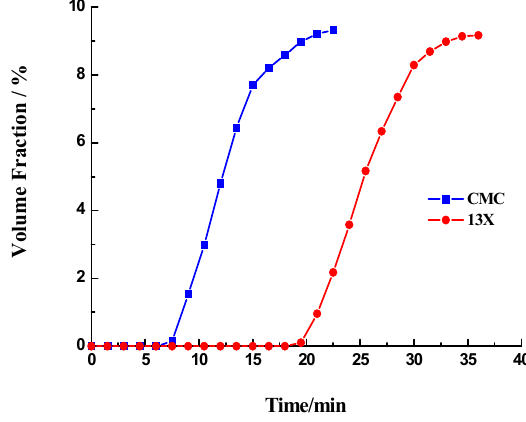
Figure 4. CO 2 breakthrough curves based on carbon molecular sieve (CMS) and 13X .